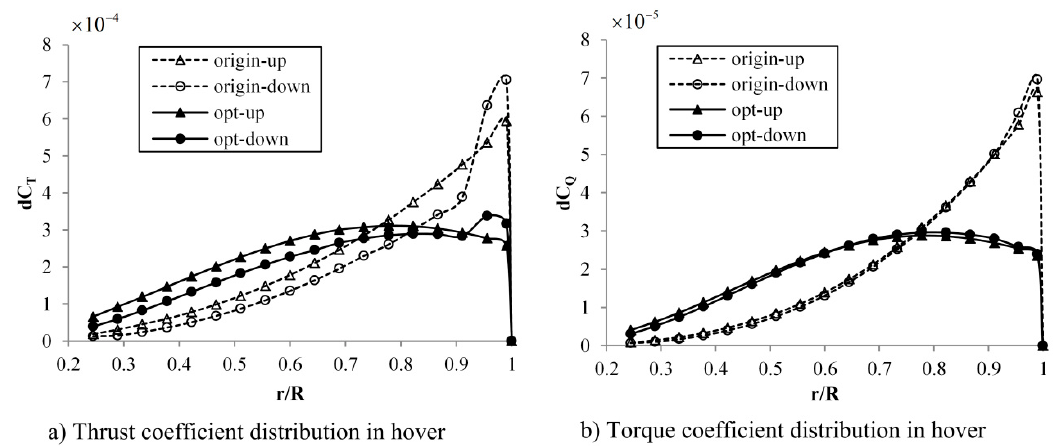
Figure 16. Global performance comparison of the original and optimized MTR in hovering and cruising states.